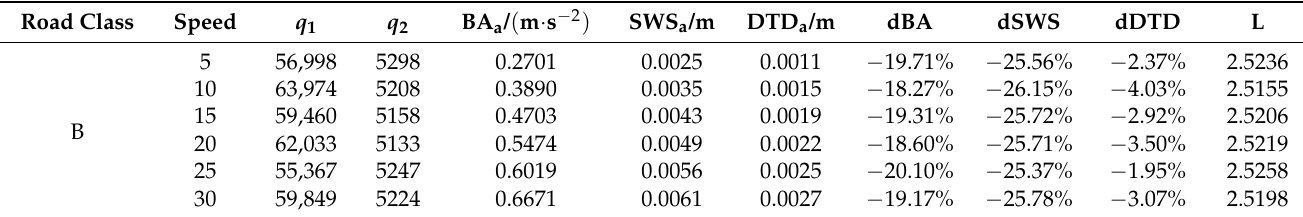
Table 7. Optimal solution and simulation results of comprehensive mode under B-class road.